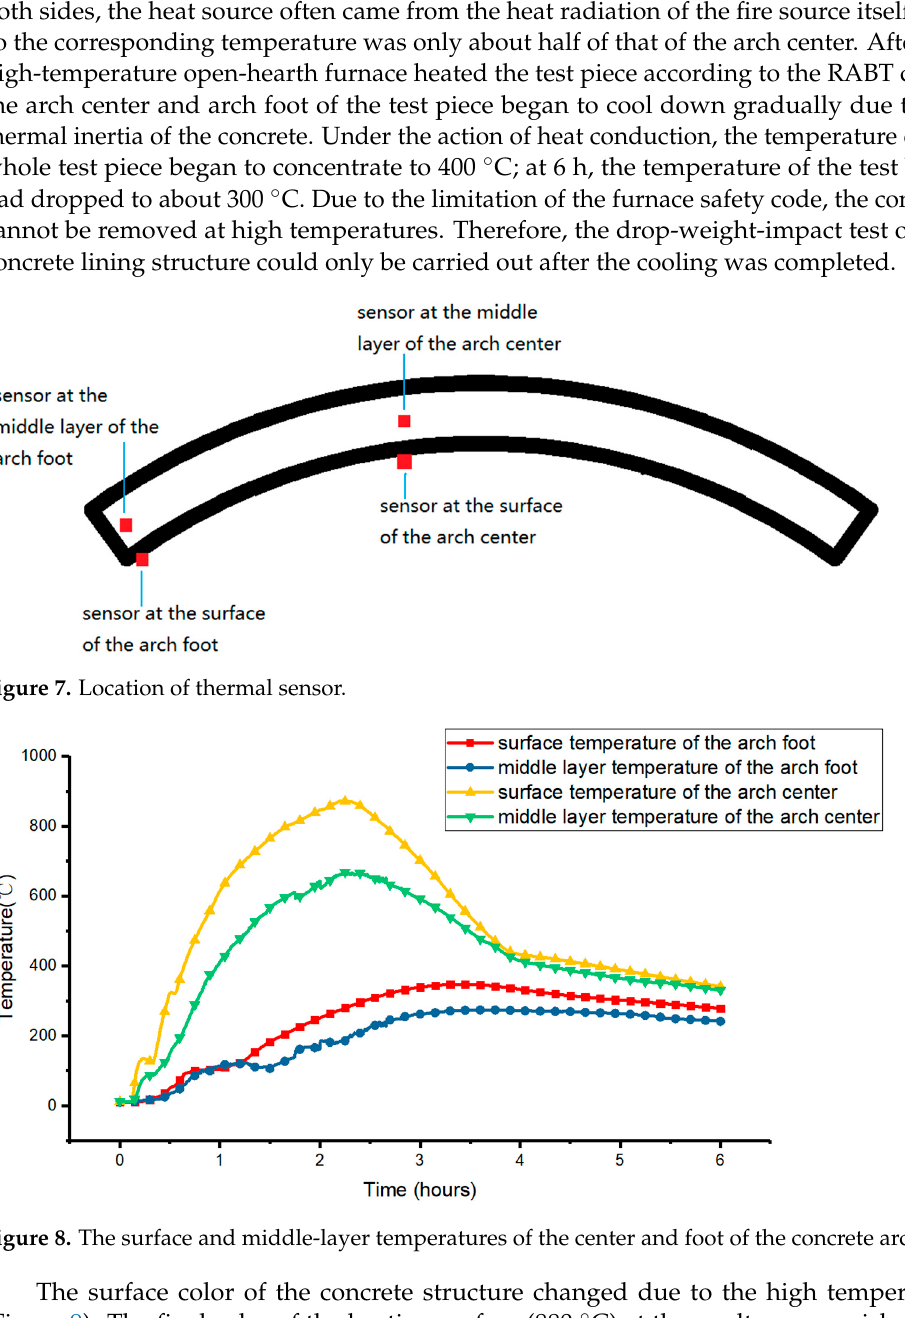
( b ) Figure 9. The surface ( a ) and cross section ( b ) of the concrete lining structure (central section). 2.2. The Drop-Weight-Impact Test of Concrete Arch (Full-Size Tunnel Lining Structure) So far, there is no standard for the impact-performance test of concrete [8]. According to the strain-rate range, the most commonly used experimental methods include the pen- dulum impact test, the MTS rapid loading test, the Hopkinson rod test, and the drop- weight-impact test [9]. Due to the limitation of the safety rules of the experimental site, the drop-hammer-impact test method was selected for this experiment. The gravity drop- weight test loads the test piece through the impact with the test piece after the heavy ham- mer falls, and so it is suitable for high-strain-rate dynamic experiments, such as 10 − 1 ~10 − 2 s − 1 . Therefore, for the high-dynamic-loading experiment of the explosion impact of the tunnel lining structure, the drop-weight-test method was used in this study.